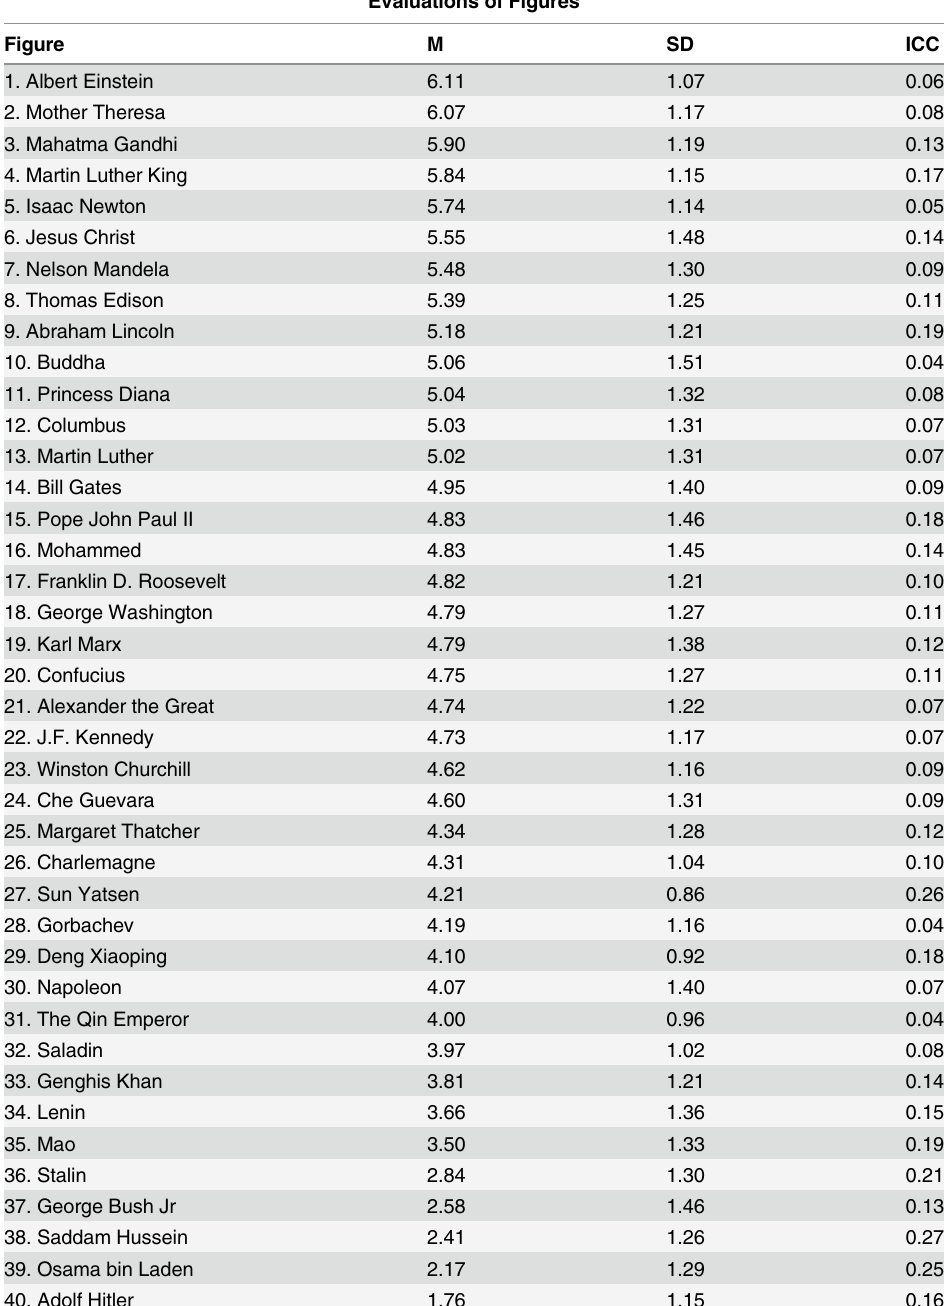
Table 1. Descending means (M) evaluations of fi gures, standard deviations (SD) and Intraclass correlation coef fi cients (ICC) across 37 nations. Evaluations of